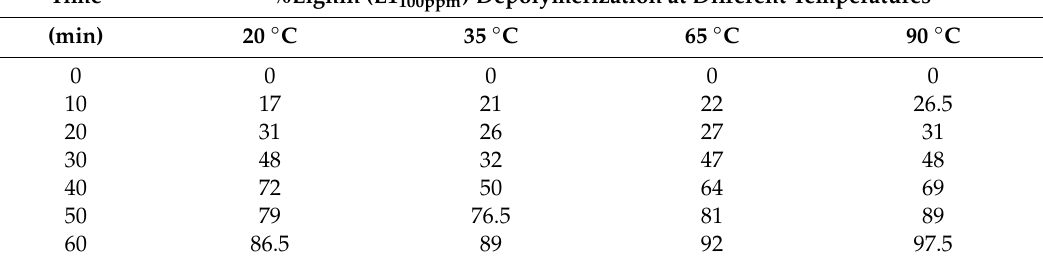
Table 5. %Lignin ( L1 100ppm ) depolymerization by SK9 (0.1 g) at the di ff erent temperatures and the time